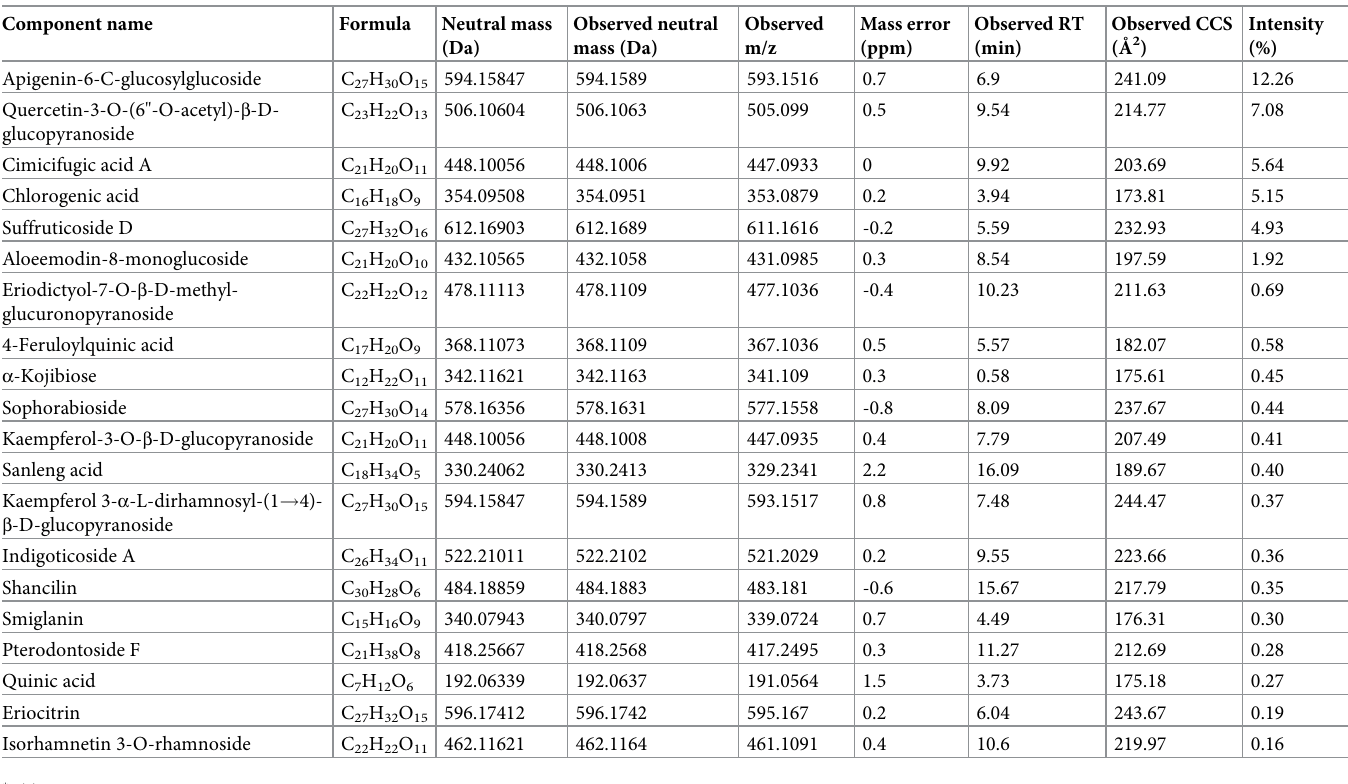
Table 1. The top 20 phytochemicals identified in MOL using the UHPLC-QTOF/MS method.